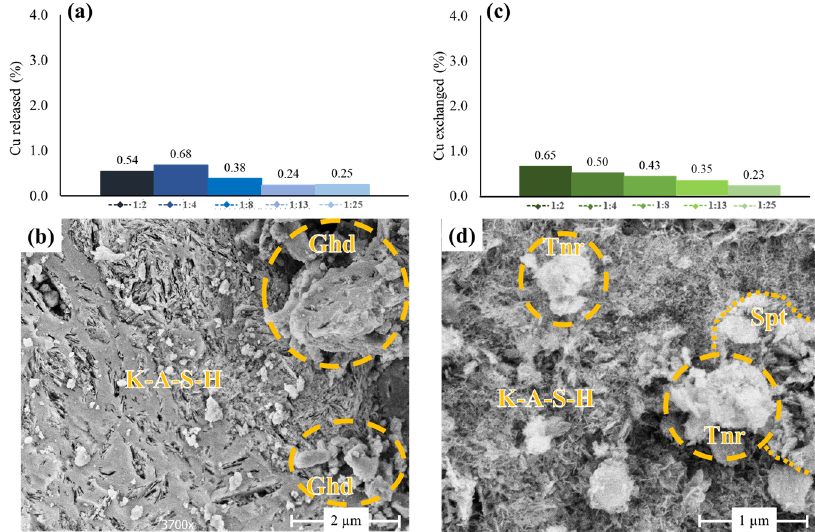
Figure 5. Compilation of results obtained from the leaching experiments. ( a , c ) Fraction of Cu 2+ liberated to the solutions upon acid leaching in the Cu:GP and Cu:GP pH series; ( b , d ) SE images of the leached samples Cu:GP-1:2 and Cu:GP pH -1:2 revealing no microstructural changes.